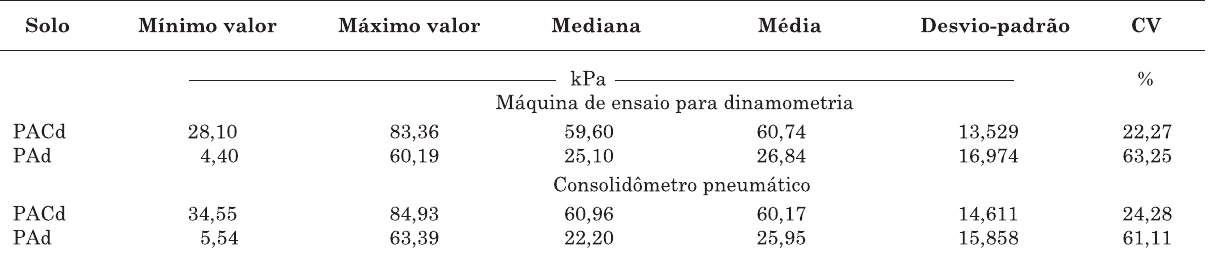
Quadro 3. Resumo estatístico da resistência tênsil de agregados do Argissolo Acinzentado distrófico arênico coeso (PACd) e do Argissolo Amarelo distrófico arênico (PAd) determinada utilizando uma máquina de ensaio para dinamometria (controle) e um consolidômetro pneumático (equipamento proposto), cujas velocidades de ensaio foram de 1,55 e 0,03 mm s -1 , respectivamente. CV: coeficiente de variação. (N =